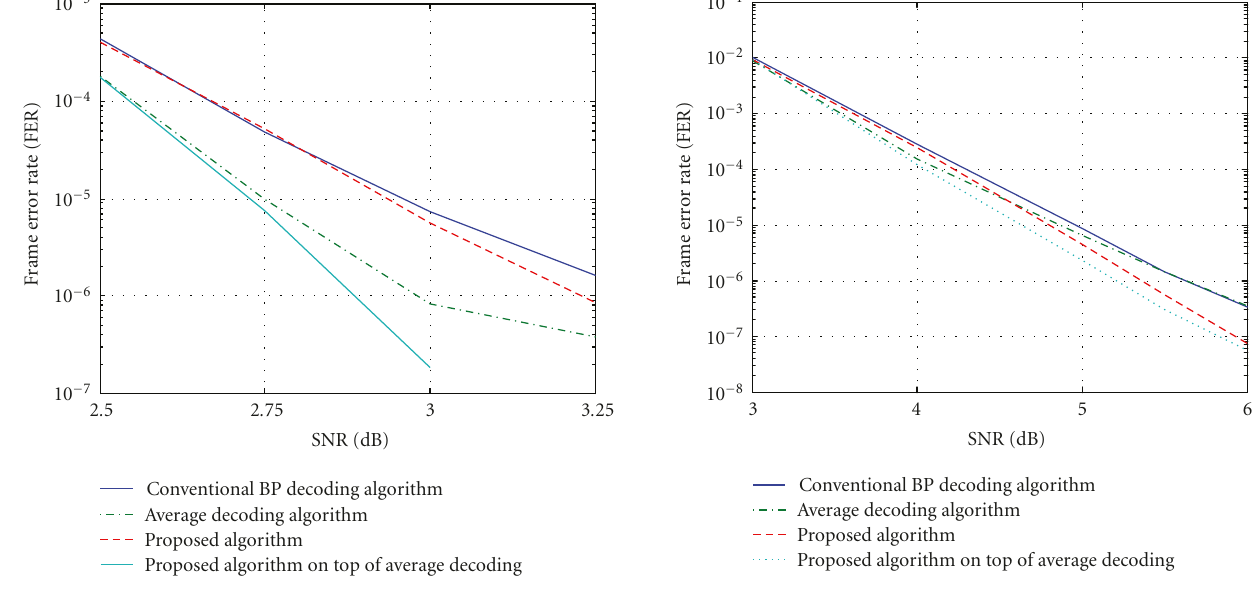
Figure 11: Performance results for HE(1024,512) LDPC code.